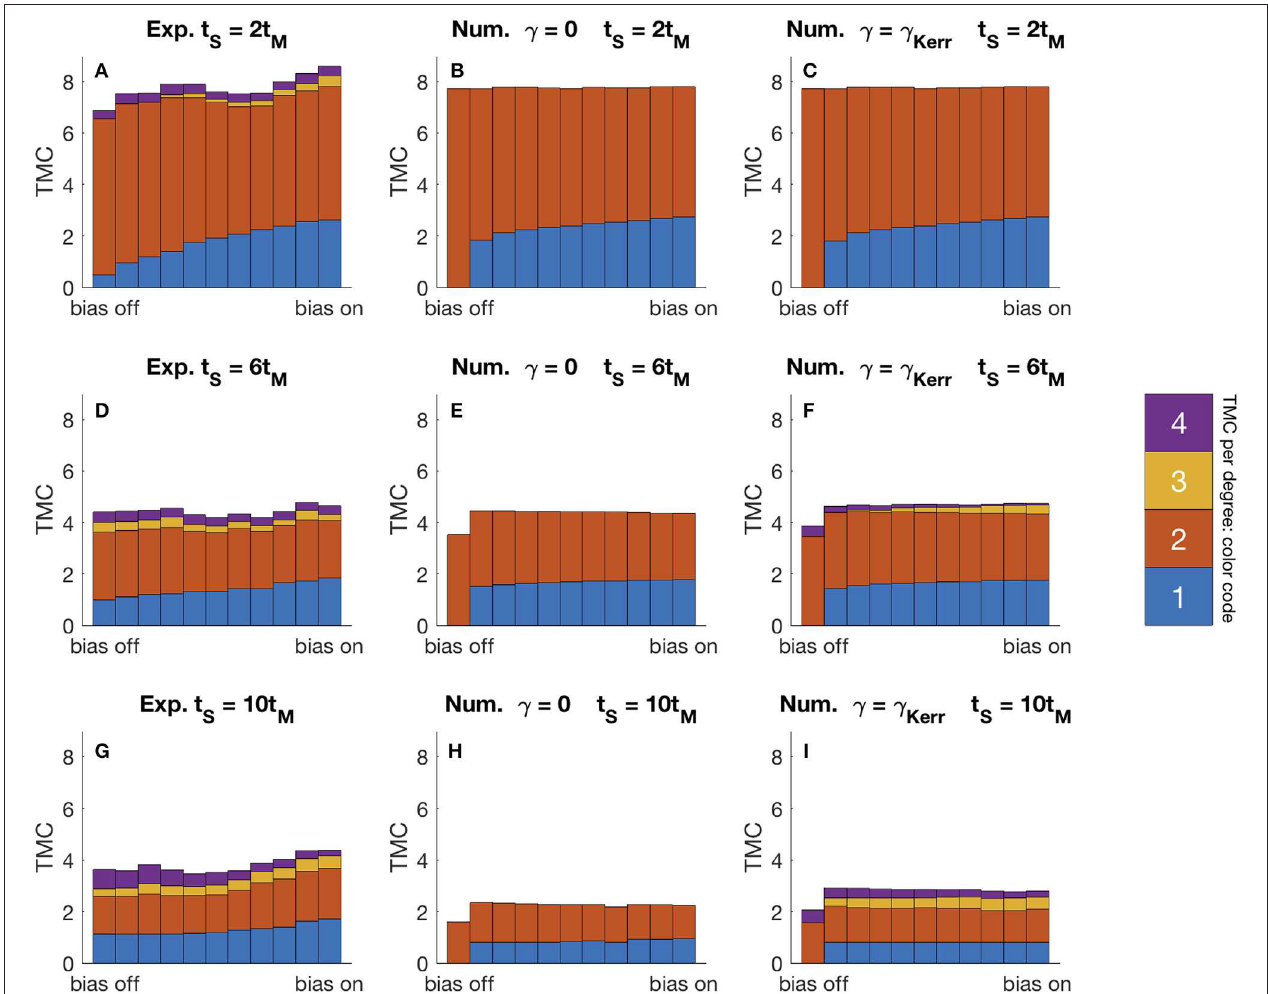
γ Kerr ) reservoirs (C,F,I) . The FIGURE 5 | Comparison between experimental results (A,D,G) and numerical models with linear ( γ 0) (B,E,H) and non-linear ( γ = = stacked vertical bars are color-coded to represent the total memory capacities (TMC) of degree 1 (blue), 2 (red), 3 (orange), and 4 (purple). As such, the total height represents the total overall memory capacity. A control variable to the MZM δ V , is varied to include a small bias component to the injected optical field, where bias off V π . The sample duration t S is varied from 2 times (A–C) , to 6 times (D–F) corresponds with δ V 0 and bias on corresponds with a small non-zero value 0 < δ V = ≪ and finally to 10 times (G–I) the input mask period t M ( cavity roundtrip time t R ≈